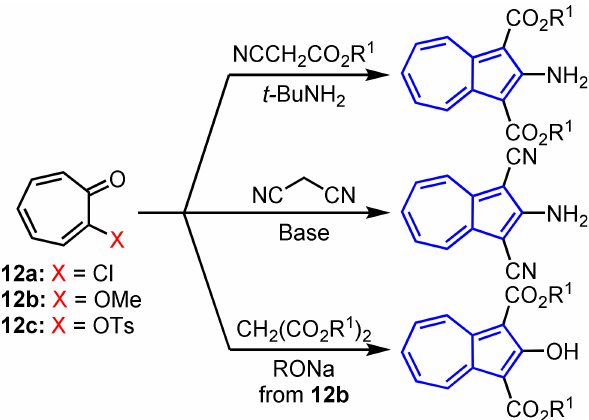
Scheme 3. Synthesis of azulene derivatives from tropone derivatives 12